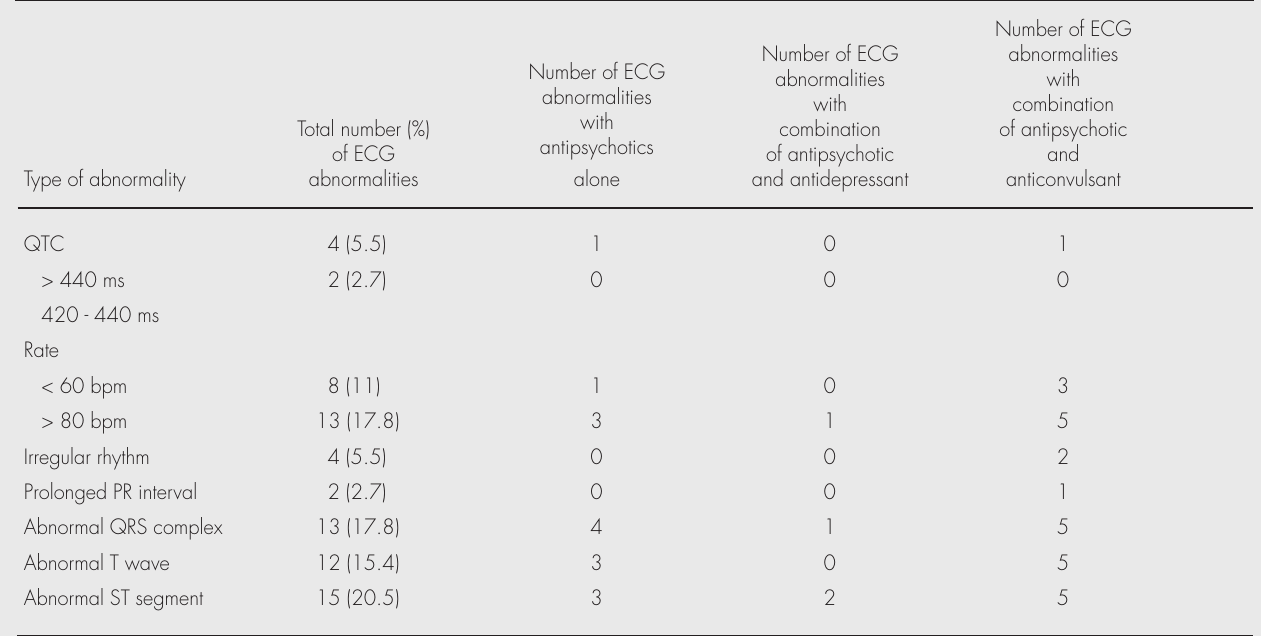
Table II. Frequency of the various types of ECG changes